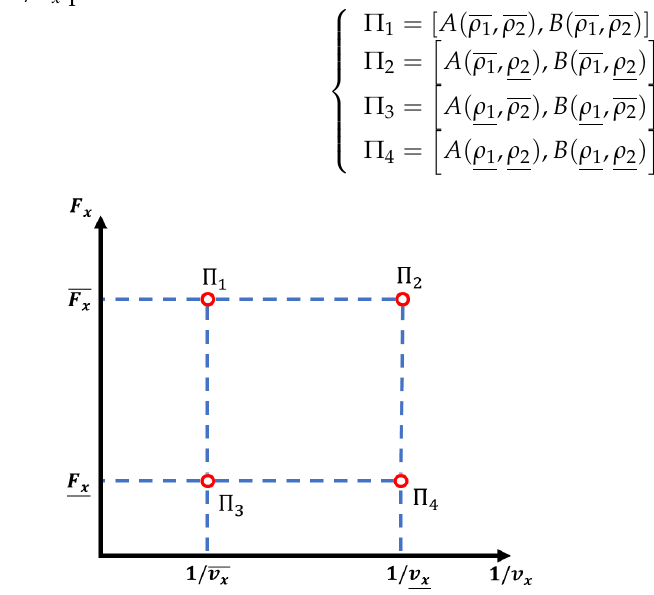
Figure 4. Graphical representation of the four-vertex